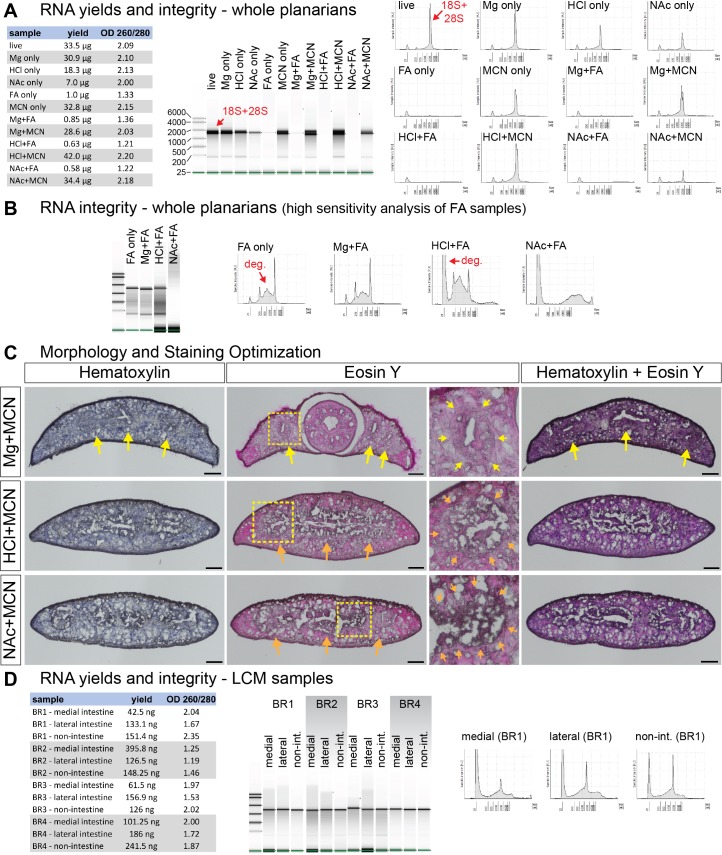
Optimization of fixation and histological staining for laser microdissection.(A) RNA yields (left table) and Bioanalyzer/TapeStation analysis of RNA integrity (right panels) from whole planarian samples (15 planarians,~20–25 mg total tissue) treated as shown. As in some other invertebrates (Ishikawa, 1977; Matz, 2002; Winnebeck et al., 2010; Asai et al., 2015), heat denaturation prior to analysis causes 28S rRNA to co-migrate as two bands with 18S rRNA (indicated with red arrows). Samples are representative of at least three independent replicates. RNA from FA-fixed samples had low yields and low 260/280 ratios. (B) Analysis of degraded RNA from FA-fixed samples using high-sensitivity (HS) TapeStation kit (for low concentration samples). Degradation of rRNA is indicated with red arrows. (C) Hematoxylin and Eosin Y labeling of transverse (cross) cryosections from methacarn-fixed planarians. Yellow arrows indicate intestine labeling in magnesium-treated samples. Orange arrows indicate compromised intestinal morphology in HCl- and NAc-treated samples. Boxed regions for Eosin Y-labeled sections are magnified to the right. (D) RNA yields (left table) and HS TapeStation analysis of RNA integrity (right panels) for all LCM samples used in this study (BR, biological replicates, 16–20 tissue sections per replicate). TapeStation lanes (middle panel) were assembled from multiple runs. Intensity plots (right panel) for BR1 are representative of other replicates. Mg, MgCl2 treatment. HCl, 2% HCl treatment. NAc, 7.5% N-Acetyl-L-Cysteine treatment. FA, 4% formaldehyde fixation. MCN, methacarn fixation. Scale bars: 100 μm (C).